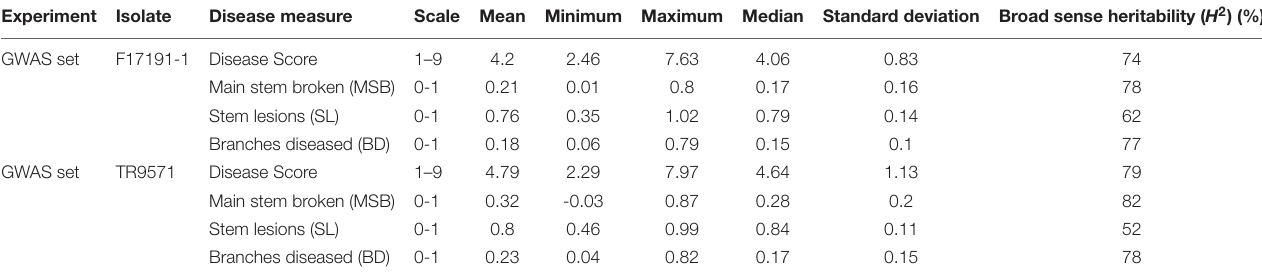
TABLE 1 | Summary of the statistical analysis of genome-wide association (GWAS) set of Australian breeding germplasm evaluated against two Ascochyta rabiei isolates. Experiment